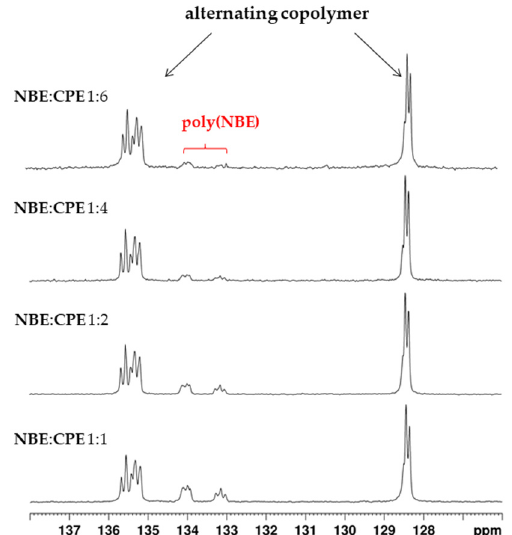
Figure 6. Olefinic region of 13 C-NMR (150 MHz) spectra of alternating NBE-CPE (norbornene cyclopentene) copolymers obtained via catalyst 4 .